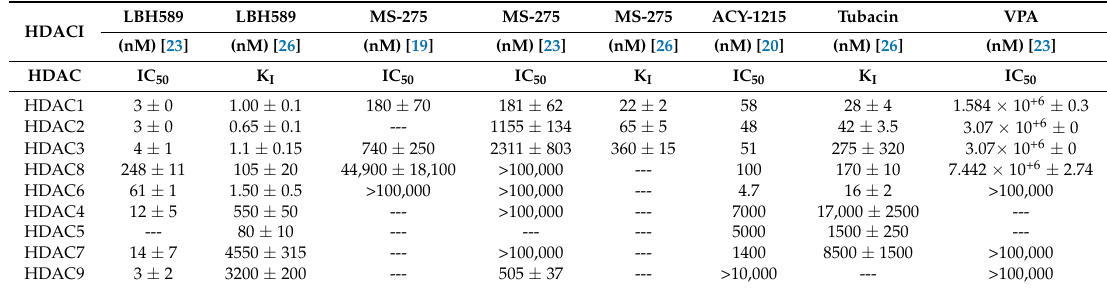
Table 2. Inhibitory constants for HDAC inhibitors used in this